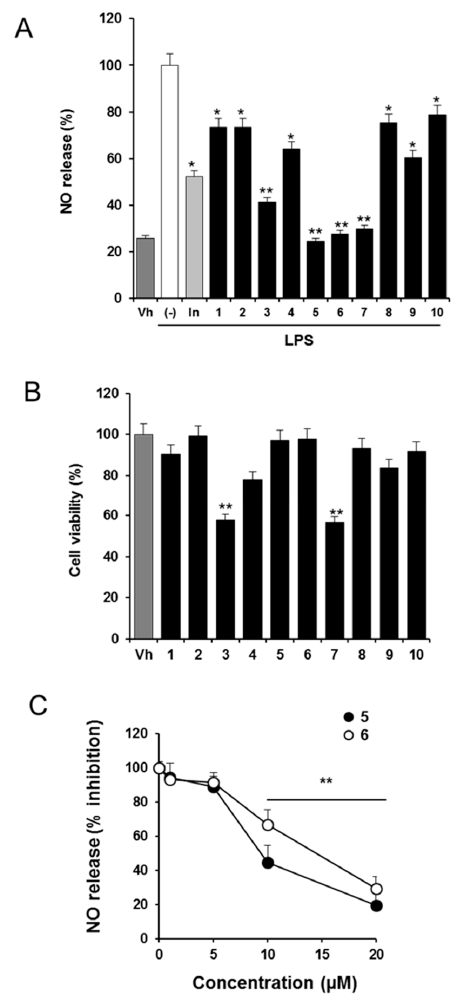
Figure 3. Effects of solidagenone derivatives on nitric oxide (NO) release and cell viability. ( A ) Peritoneal macrophages were treated with vehicle (Vh), lipopolysaccharide (LPS) (200 ng/mL), LPS and 10 µ M of indomethacin (In), or LPS and 20 µ M of solidagenone derivatives ( 1 – 10 ) for 24 h. The accumulation of nitrite in the culture medium was measured with the Griess method and expressed as the percentage of NO release compared to LPS treatment. ( B ) Peritoneal macrophages were treated with vehicle (Vh) or 20 µ M of solidagenone derivatives ( 1 – 10 ) for 24 h. Cell viability was determined by MTT assay. ( C ) Dose-dependent effects of compounds 5 and 6 (5–20 µ M) on NO release. Experiments were carried out in triplicate and results are the means ± SD of three independent experiments. * p < 0.05 and ** p < 0.01 with respect to the LPS